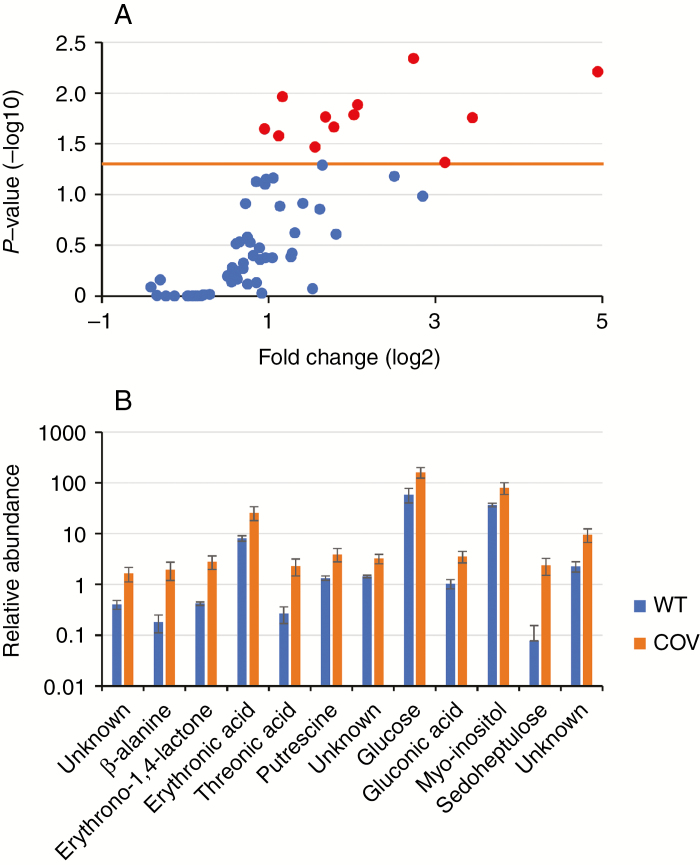
Differentially regulated metabolites in arabidopsis cell culture associated with the overexpression of the JA receptor COI1. Significant metabolite changes in COV1 cell culture compared with Ler (both untreated) using GC-MS. (A) Volcano plot of metabolomics data. The x-axis is the mean ratio fold change (plotted on a log2 scale) of the relative abundance of each metabolite between untreated Ler and COV1. The y-axis represents the statistical significance P-value (plotted on a –log10 scale) of the ratio of relative abundances for each metabolite. Metabolites highlighted in red (and also represented in B) hyperaccumulate in COV1 cell culture and have significant P-values (orange threshold bar represents P < 0.05) and high fold change values (>2). (B) The vertical scale bars (log10) represent the relative metabolite abundance normalized to the total peak areas. Metabolites shown are significantly different (P < 0.05) according to pair-wise comparison using Tukey HSD test. Data represent the means of four independent biological replicates and error bars represent the s.e.